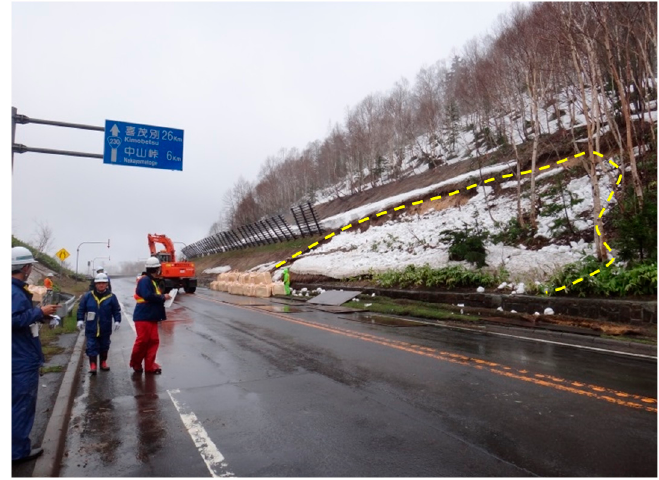
Figure 1. Slope failure induced by snowmelt infiltration (May 2012, Nakayama Pass, National Highway 230, Sapporo. This photo is from a study on a snowmelt estimation method for road management).